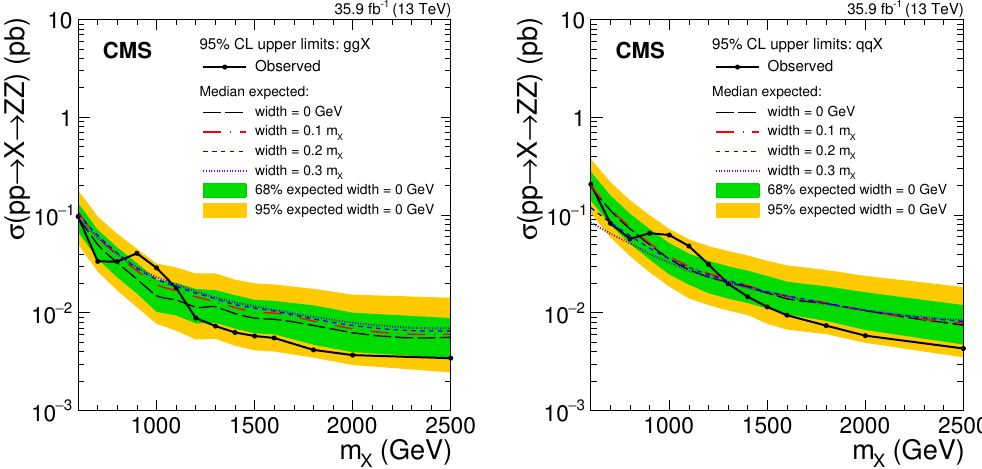
Figure 7 . Expected and observed limits on the product of cross section and branching fraction of a new spin-2 heavy resonance X ! ZZ based on a combined analysis of the electron and muon channels. The more generic version of the bulk graviton model is considered, assuming either gluon- gluon fusion (left) or qq annihilation (right) processes. Expected limits are also shown for models having various decay widths relative to the mass of the